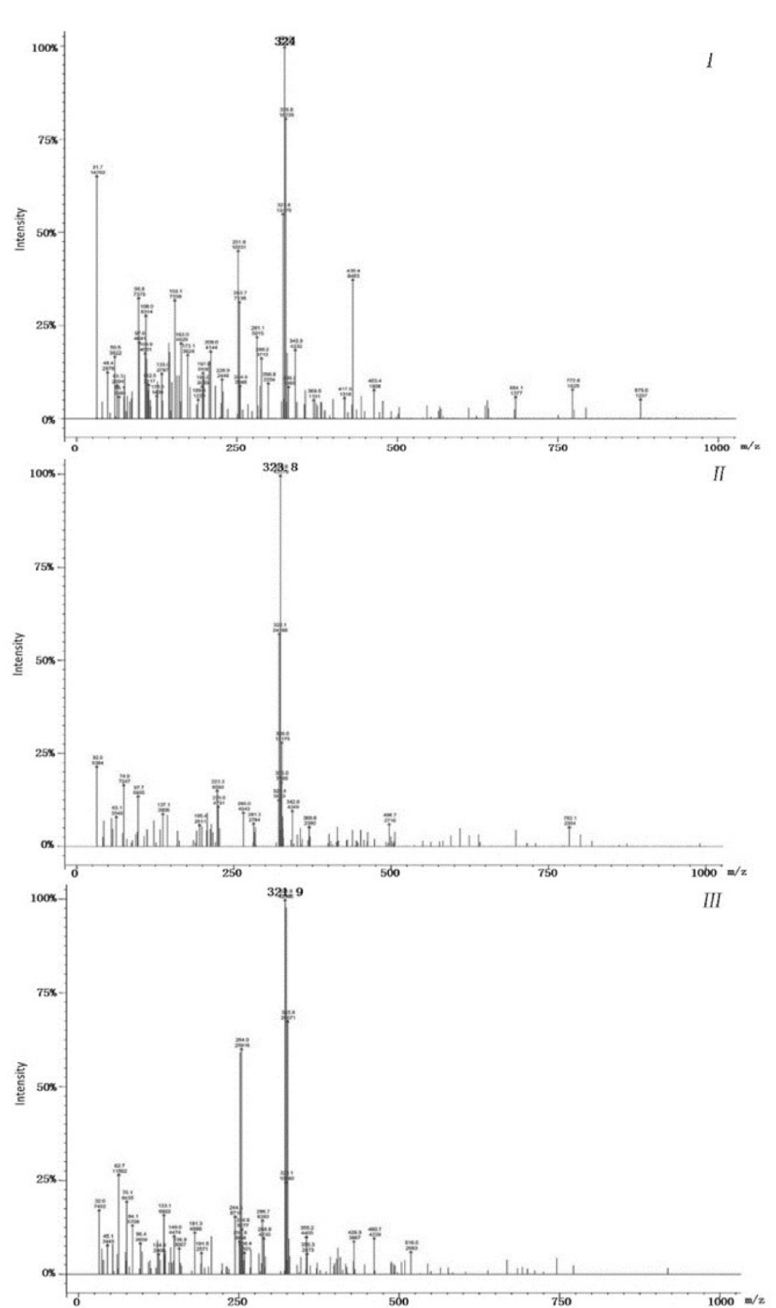
Figure 10. Mass spectrum (MS) of degradation products of 2,6-DCP degraded by LAC-4. Three products were detected by GC-MS analysis: the m/z values of substances I, II and III were 324, 323.8 and 321.9,